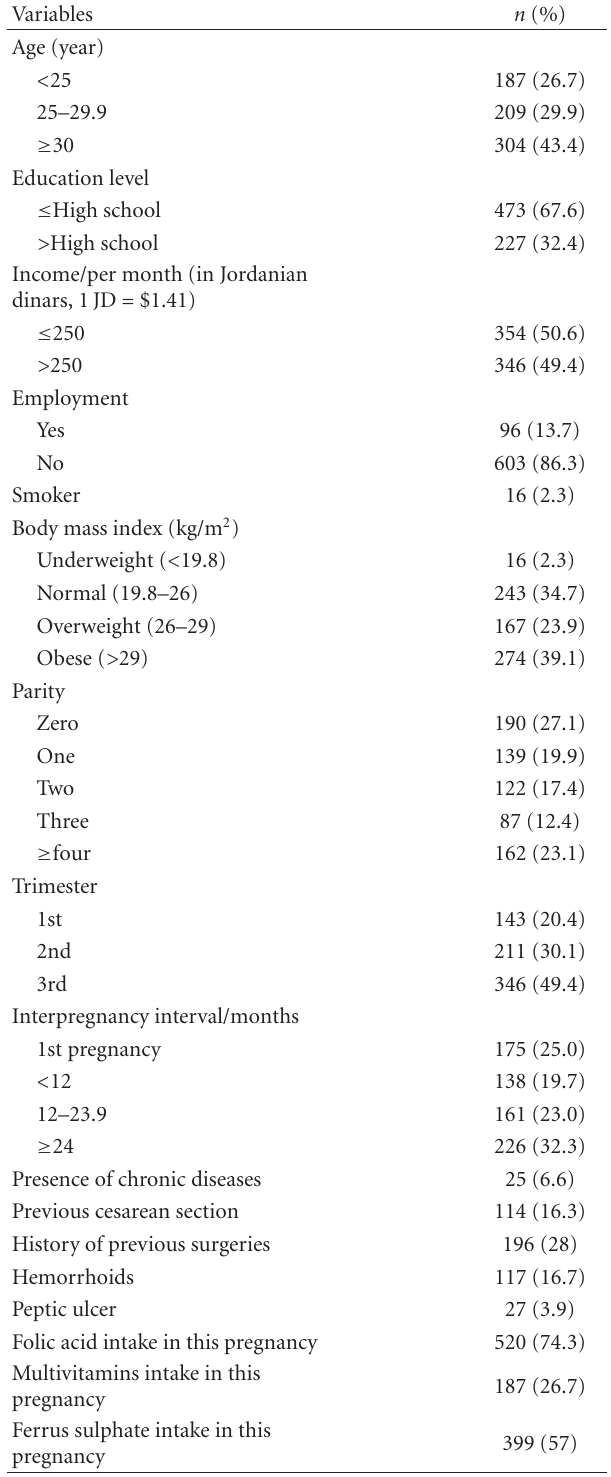
Table 1: Sociodemographic, obstetric, and relevant